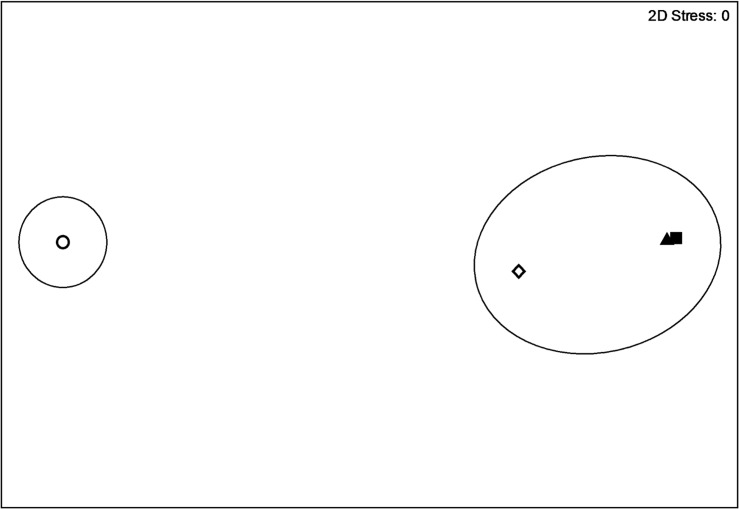
Non-metric multi-dimensional scaling of general environmental conditions at M2 mooring.Environmental conditions in 2009 (filled triangle), 2010 (open diamond), 2011 (filled square), and 2012 (open circle) based on the data from Table 1. Data were normalized to mean and standard deviation and Euclidean distance was used to calculate resemblance. Significant dissimilarities between environments in 2012 and the other three years (p < 0.05) are indicated by the black circles (Euclidean distance = 5) and are based on the permutation-based SIMPROF test (Primer v. 6). Axes are unit-less.